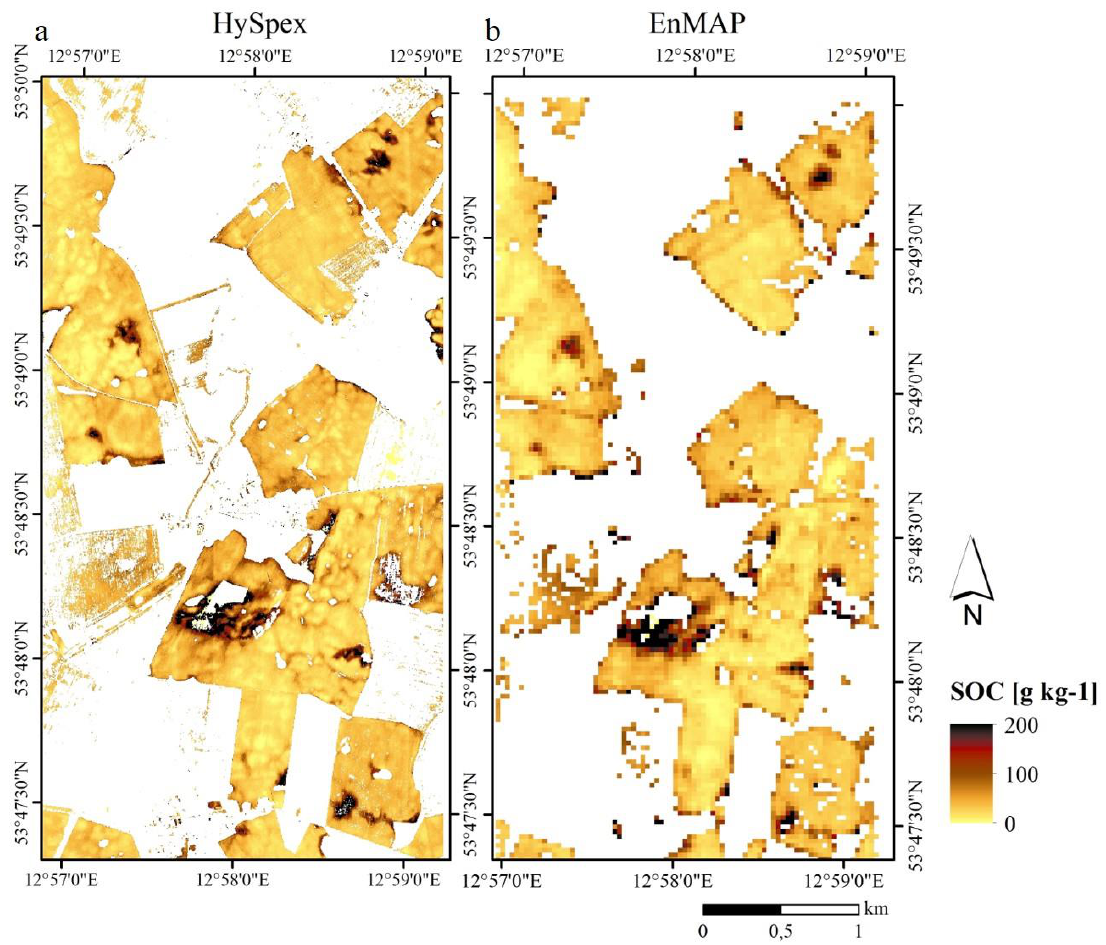
Figure 8. SOC maps for airborne HySpex ( a ) and simulated satellite EnMAP imagery ( b ) using the two-step PLSR approach applied to all bare soils. Remote Sens. 2020 , 12 , x FOR PEER REVIEW 14 of 21